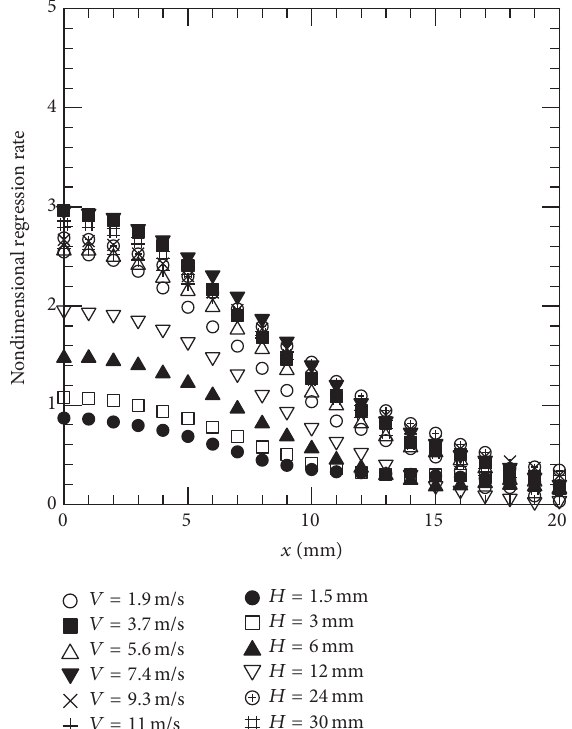
Figure 5: Nondimensional regression rate.